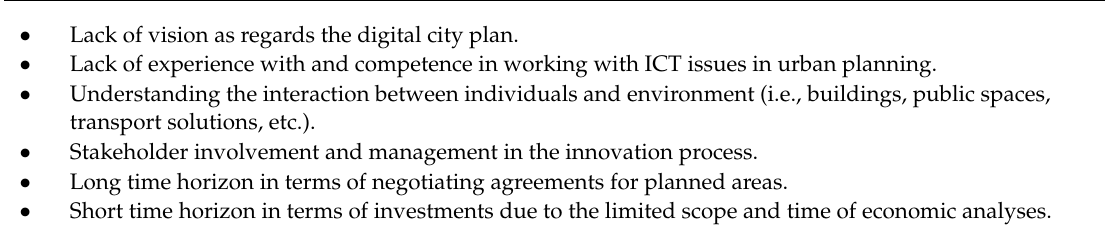
Table 4. Challenges for the development of